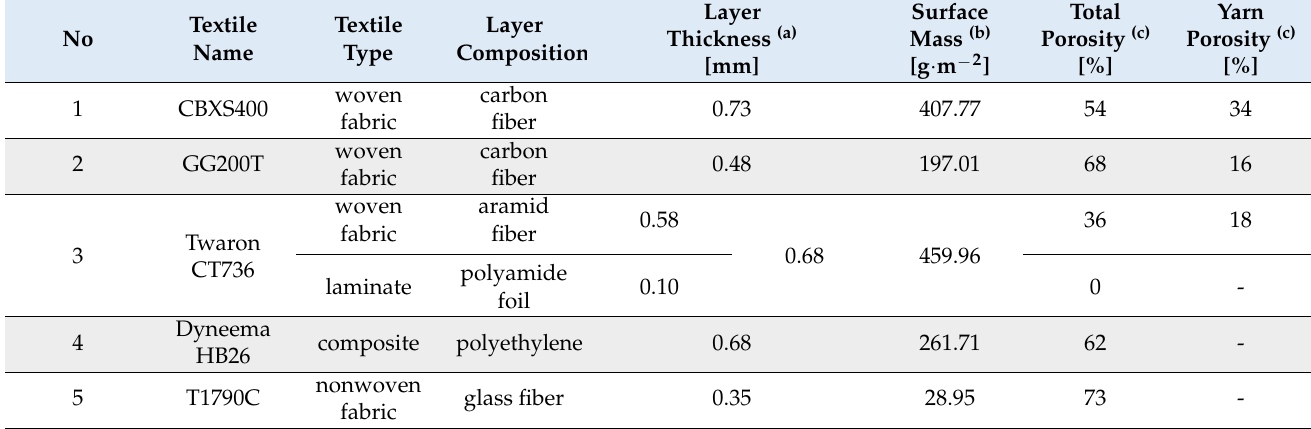
Table 1. Characteristics of five tested